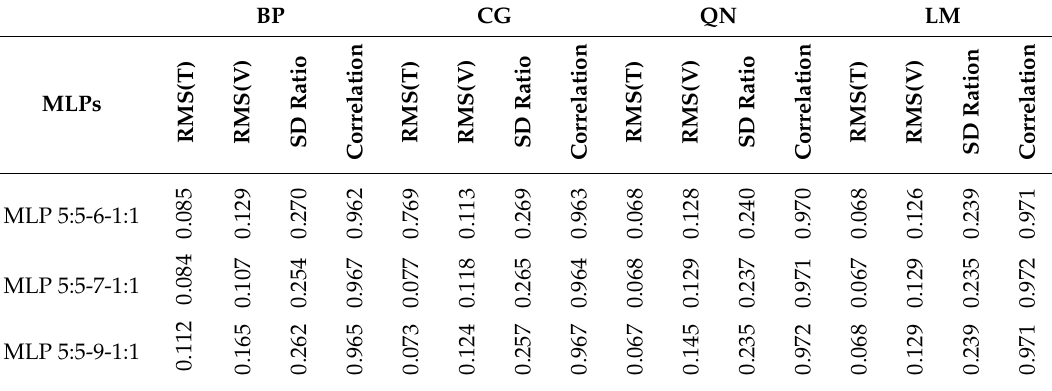
Table 3. E ff ect of the learning algorithm on the statistics of Multilayer Perceptrons (MLPs). BP CG QN